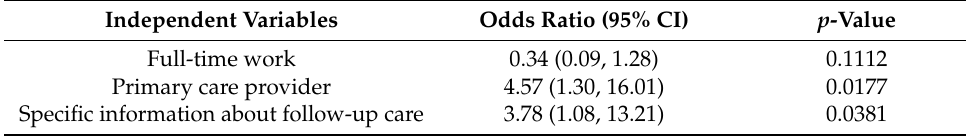
Table 4. Independent predictors for abnormal Pap follow-up 1